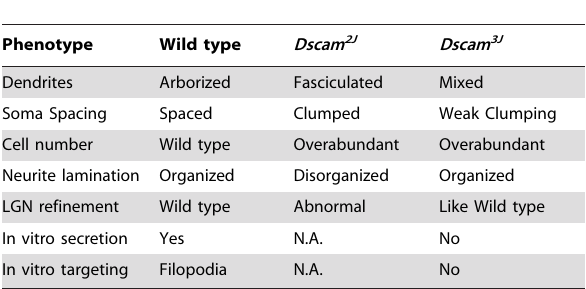
Table 1. Phenotypes in Dscam 3J